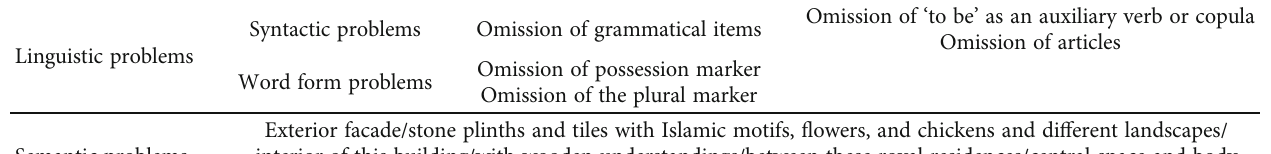
Table 6: Linguistic and semantic problems of English translation of the Pars museum brochure.